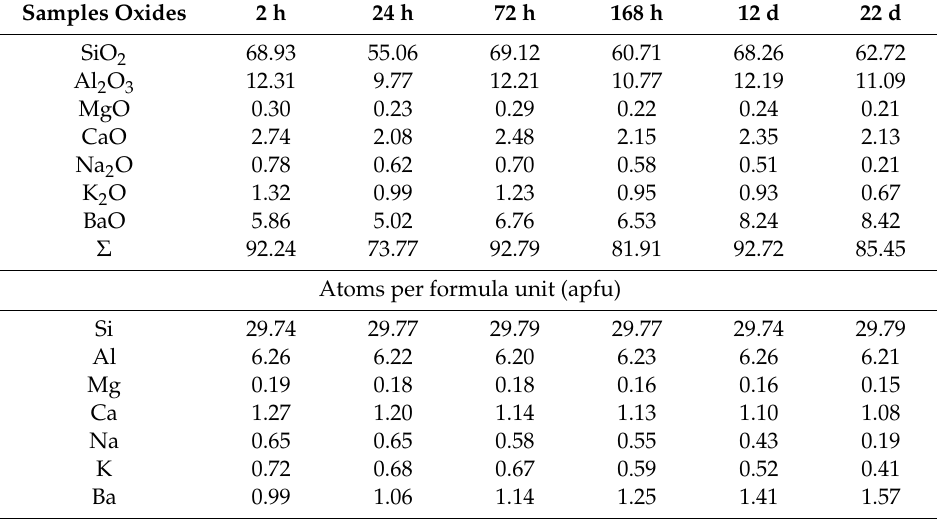
Table 3. Chemical composition (EDS, wt%) and structural formulae of Ba-clinoptilolite (RT) based on 72 oxygen atoms.